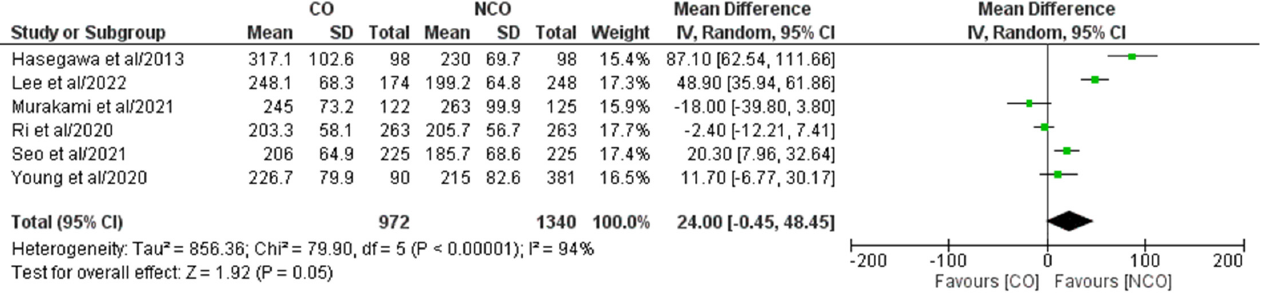
Figure 4. Forest plot comparing operative time between the CO and NCO groups. CI, confidence interval; M–H, Mantel–Haenszel [16,18,19,21,27,30].